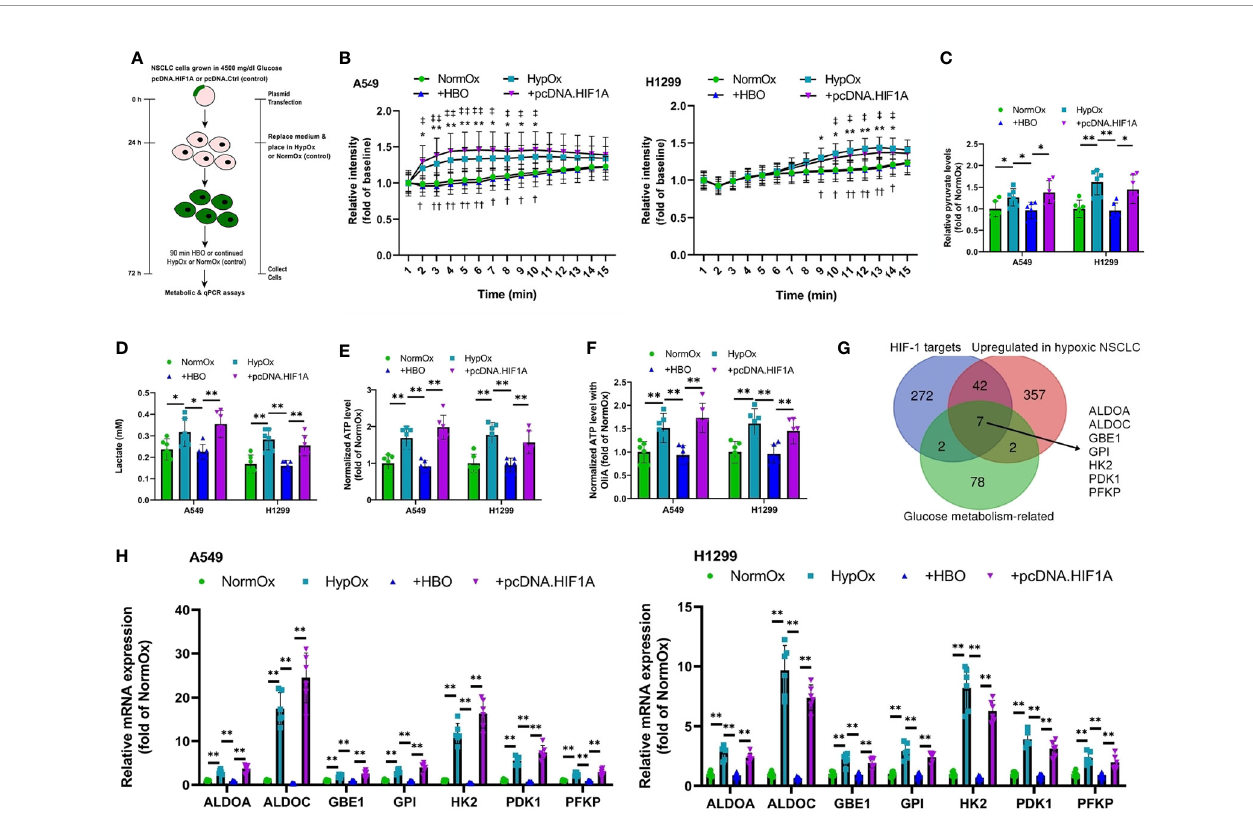
FIGURE 1 | HBO suppresses the hypoxia-induced Warburg effect in NSCLC cell lines via HIF-1 a . (A) A549 and H1299 NSCLC cells were subjected to hypoxia (HypOx) with or without hyperbaric oxygen (HBO) and pcDNA.HIF1A transfection. (B) Glucose uptake in A549 and H1299 cells. (C) Intracellular pyruvate levels in A549 and H1299 cells. (D) Lactate secretion in A549 and H1299 cells. (E, F) Intracellular ATP levels in A549 and H1299 cells incubated (E) without or (F) with oligomycin A for 1 h. (G) Venn analysis identi fi es seven HIF-induced, upregulated glucose metabolism genes in hypoxic NSCLC cells. (H) qPCR analysis of expression of the seven glucose metabolism genes identi fi ed in (G) in A549 and H1299 cells. Peptidylprolyl isomerase A (PPIA) was used as the housekeeping gene. Data represented as means ± SDs. n = 3 biological replicates × two technical replicates. * P < 0.05, ** P < 0.01 [one-way